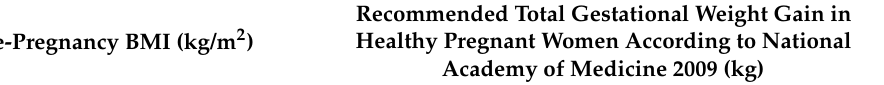
Table 1. Recommendations for healthy women: Total gestational weight gain according to National Academy of Medicine guidelines 2009, based on pre-pregnancy BMI including a daily intake of a minimum of 175 g of carbohydrate irrespective of pre-pregnancy BMI [27,57].